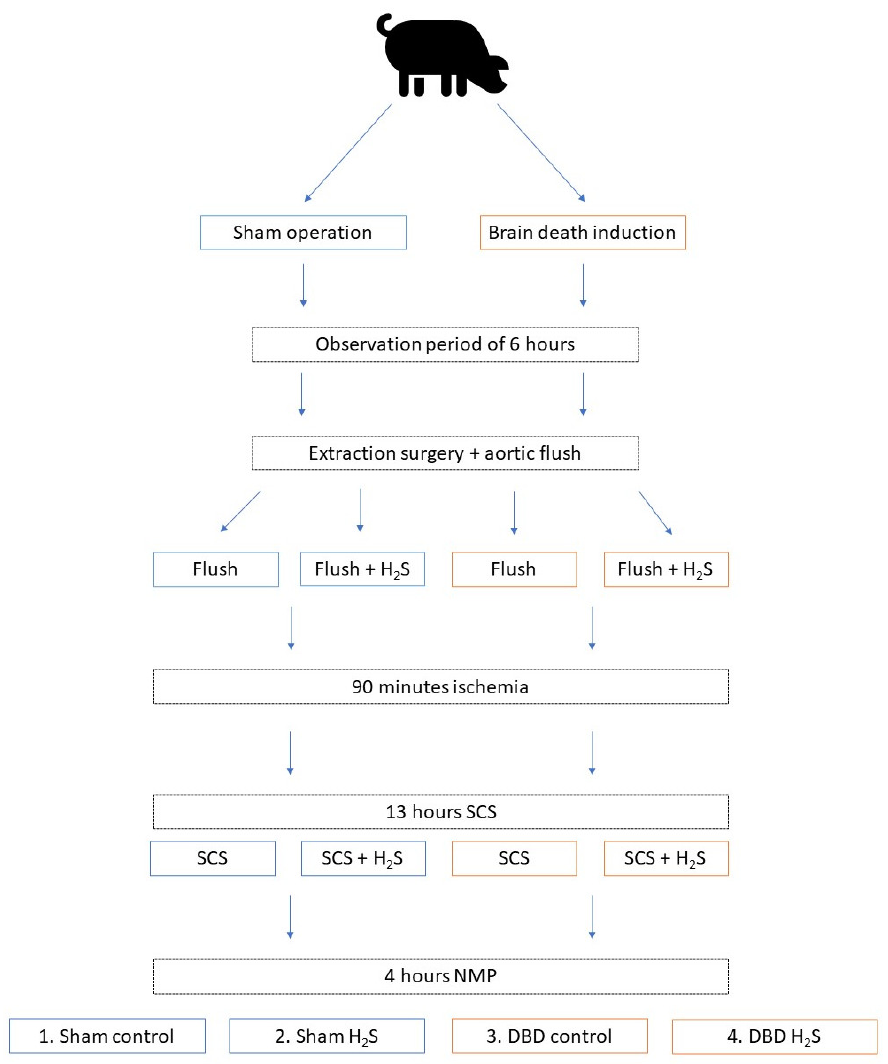
Figure 1. Experimental overview. Group 1 Sham control, group 2 Sham + H 2 S treatment, group 3 DBD control, group 4 DBD + H 2 S treatment. Abbreviations: DBD = donation after brain death. H 2 S = hydrogen sulphide. NMP = normothermic machine perfusion. SCS = static cold storage.